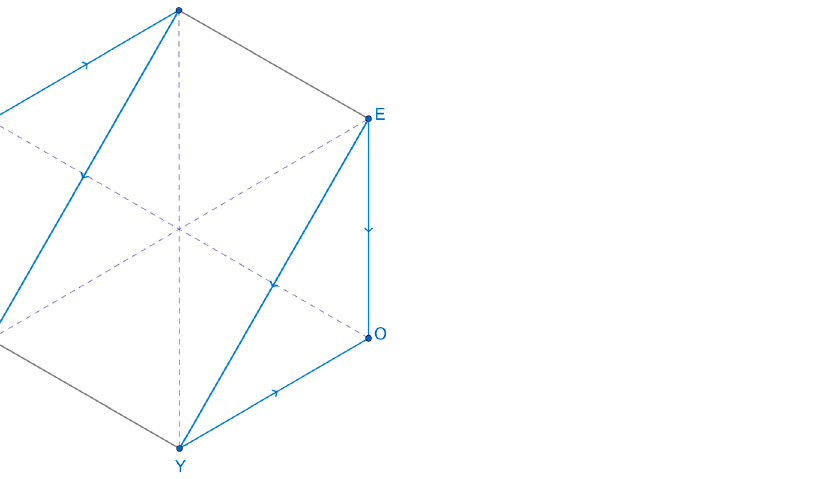
Figure 8. Czezowski’s Hexagon, showing subalternation and contradiction among propositions located at vertices A, E, I, O, Y, and U.